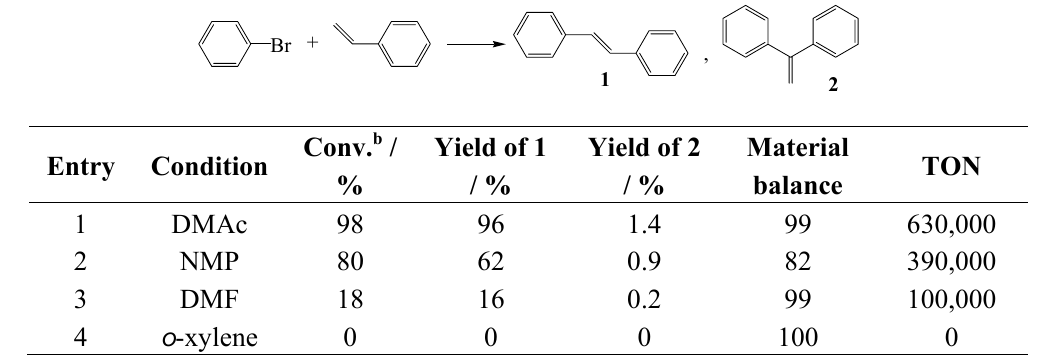
Table 3. Heck reactions between bromobenzene and styrene catalyzed by Pd/USY in various kinds of solvents. a